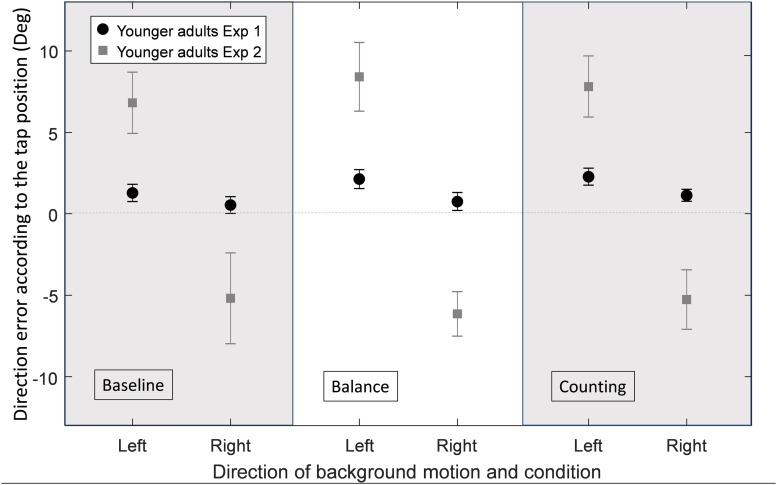
Average direction error in degrees for YA in the original experiment (Exp1, n = 19) and in the current experiment (Exp2, n = 19), for each experimental condition (baseline, balance and counting) and for each background direction of motion (left or right) merged between the different directions of the target’s motion (horizontal velocities: −7.2, 0, and 7.2 cm/s). Error bars represent the standard error of the mean between subjects.